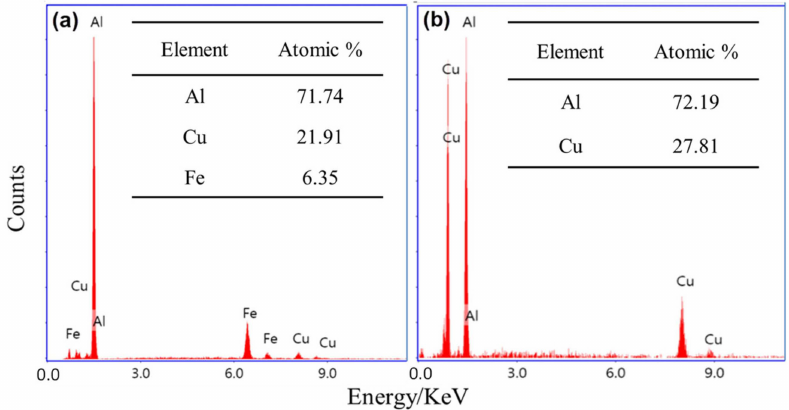
Figure 9. EDS analyses of precipitates show two types of intermetallic precipitates: ( a ) Al 7 Cu 2 Fe (spot 1 analysis in Figure 8) and ( b ) Al 2 Cu (spot 2, 3, and 4 in Figure